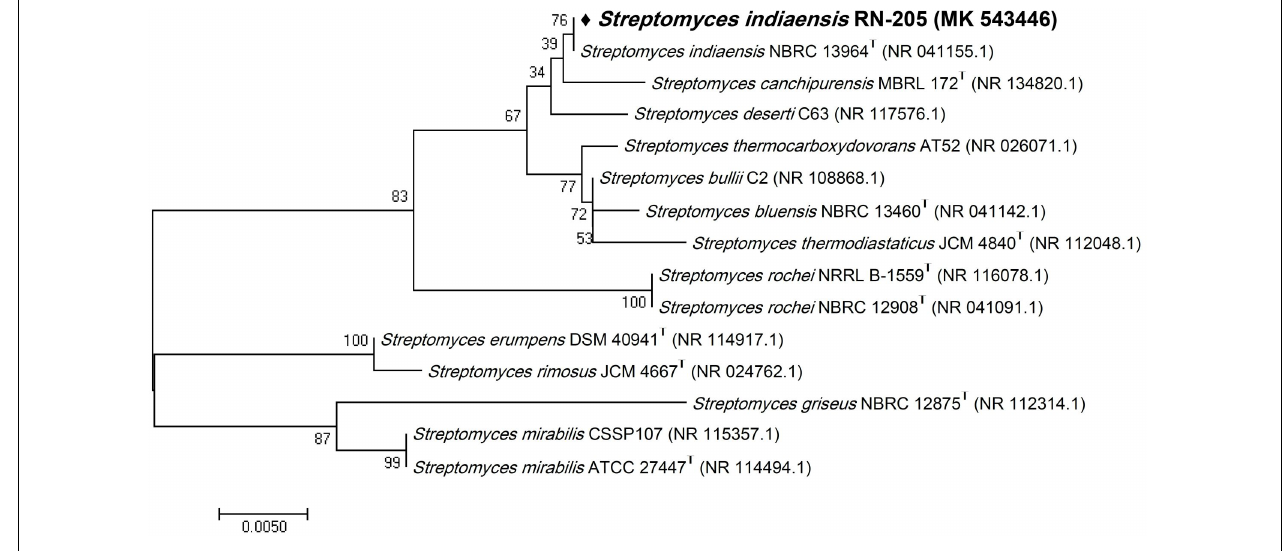
FIGURE 2 | Phylogenetic tree of the River Nile derived Streptomyces indiaensis RN-205 based on partial 16S rRNA gene sequences. The phylogenetic tree was inferred using the Neighbor-Joining method (Saitou and Nei, 1987). The distances were computed using the Kimura 2-parameter method (Kimura, 1980) and are in the units of the number of base substitutions per site. Numbers at nodes indicate percentages of 1000 bootstrap re-samplings. All positions containing gaps and missing data were eliminated. Evolutionary analyses were conducted in MEGA7 (Kumar et al., 2016).